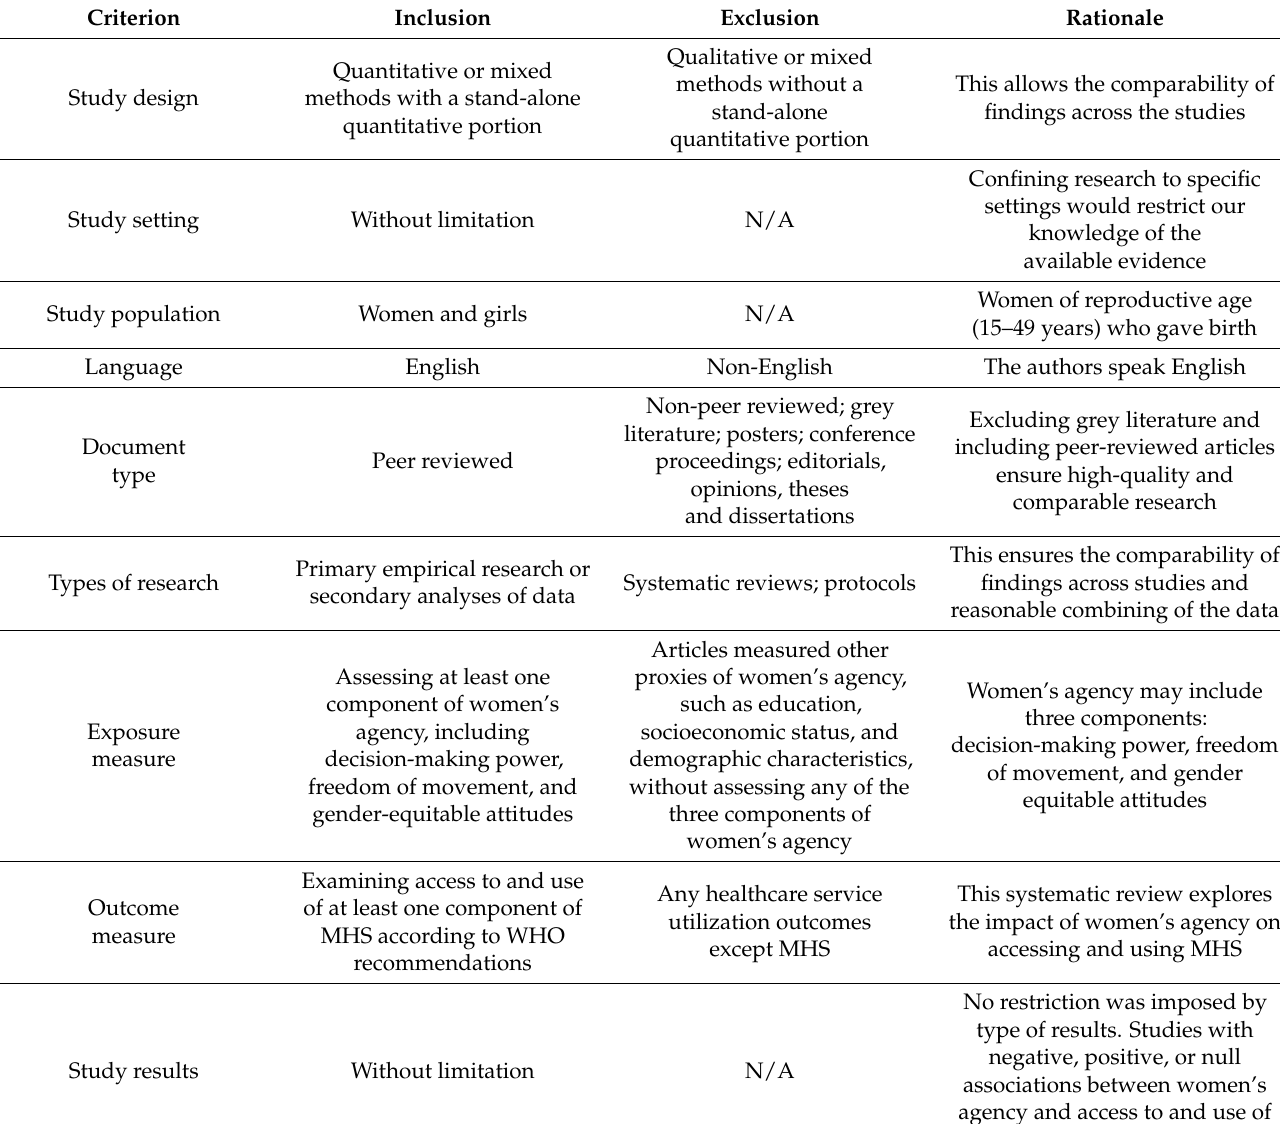
Table 3. Inclusion/exclusion